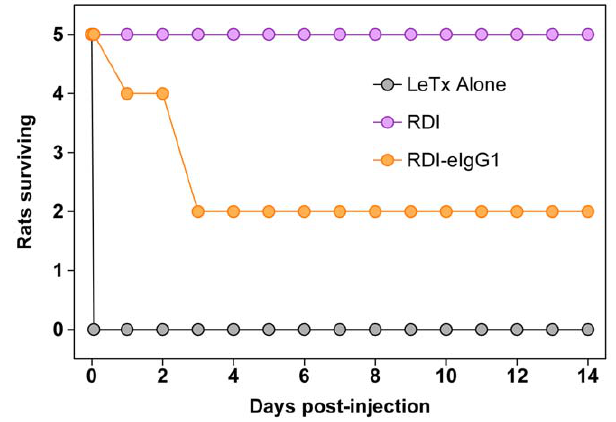
Figure 2. Survival of mice following spore challenge. Female A/J mice (8–10 weeks) were given approximately 2.9 6 10 4 Sterne strain spores delivered in 100 m l of water IP. The CMG2-IgG was delivered IP in approximately 100 m g doses at 1 h, 28 h, and 52 h post infection. A final 50 m g dose of CMG2-IgG was administered at 96 h post-infection. Statistically significant P values were achieved for mean time to death or euthanasia by T-test (P=0.03), and log-rank Mantel-Cox survival curve (P=0.009).